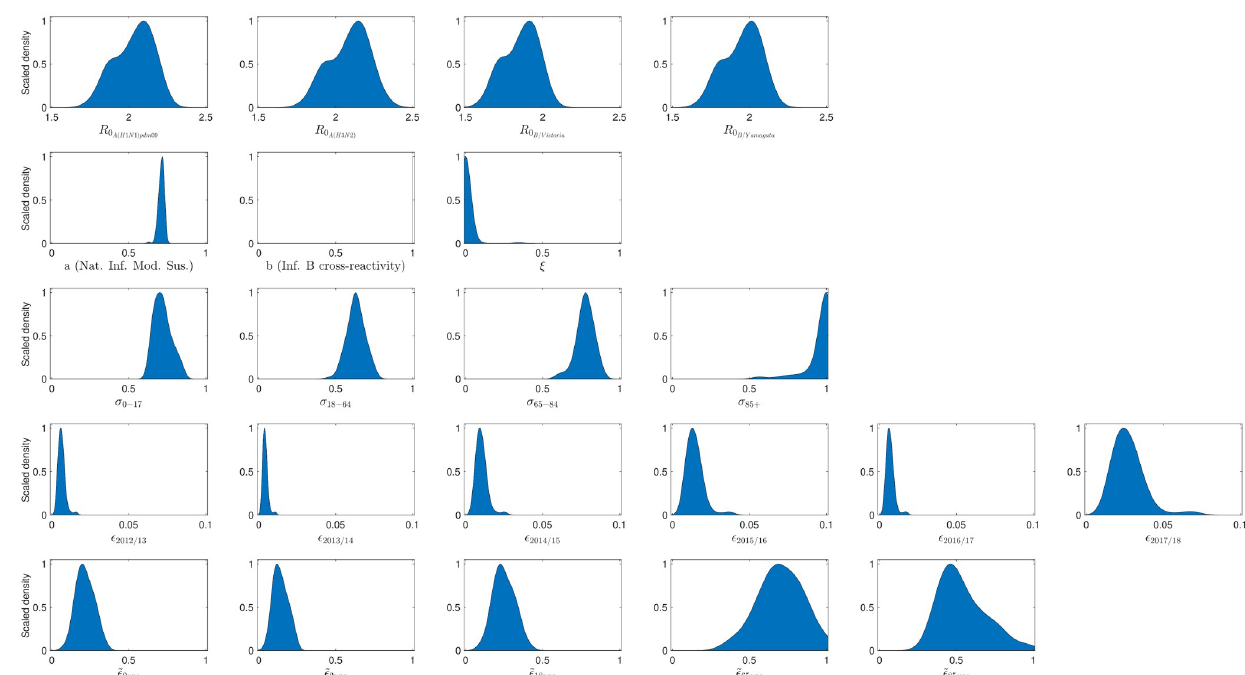
Fig 2. Acquired parameter distributions from the optimisation scheme, fitting to the empirical data. Parameter densities generated from 100 particles that each returned an error below 30,000. Blue shaded areas outline the scaled density. ( Row one ) Basic reproduction numbers by strain. ( Row two ) Immunity propagation parameters. ( Row three ) Susceptibility by age group. ( Row four ) Ascertainment probabilities for those aged 100+, by influenza season. ( Row five ) Relative ascertainment by age. Particularly noteworthy outcomes include: prior season influenza B cross-reactivity and vaccine carry over had little impact on present influenza season susceptibility; the highest ascertainment probability for the 100+ age group occurred in the 2017/18 influenza season; amongst the knot ages to produce the piecewise linear ascertainment function, the greatest ascertainment was observed for those 65 years of